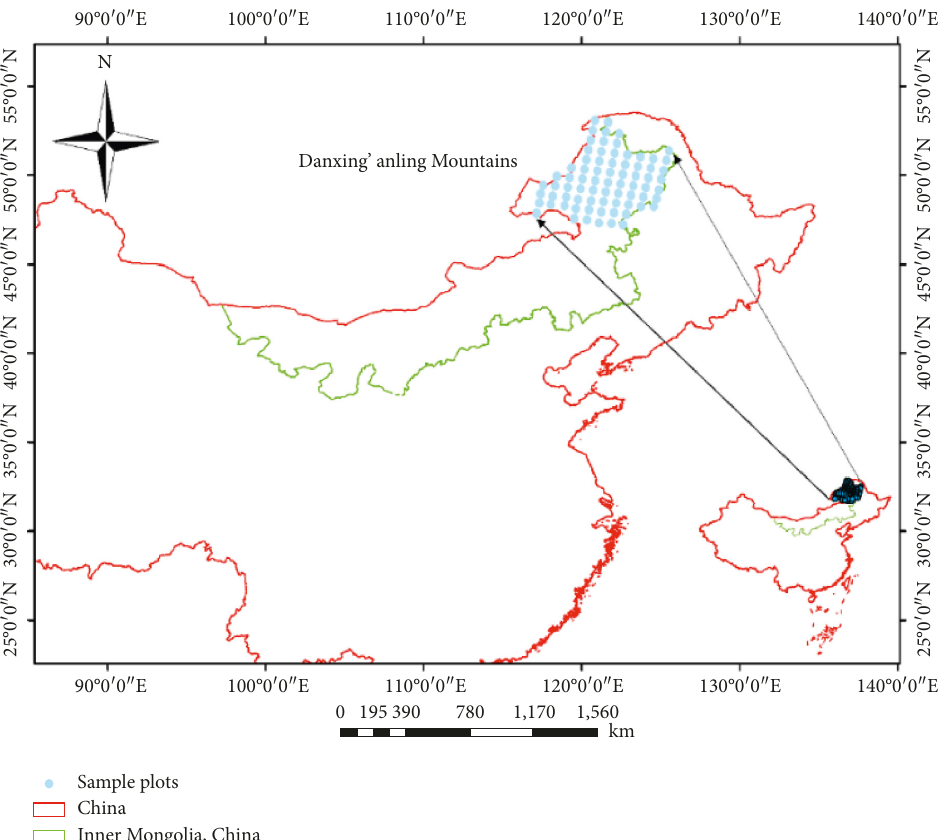
Figure 1: Sketch plots map of geographic division of Daxing’anling Mountain, northeastern Mongolia, China.